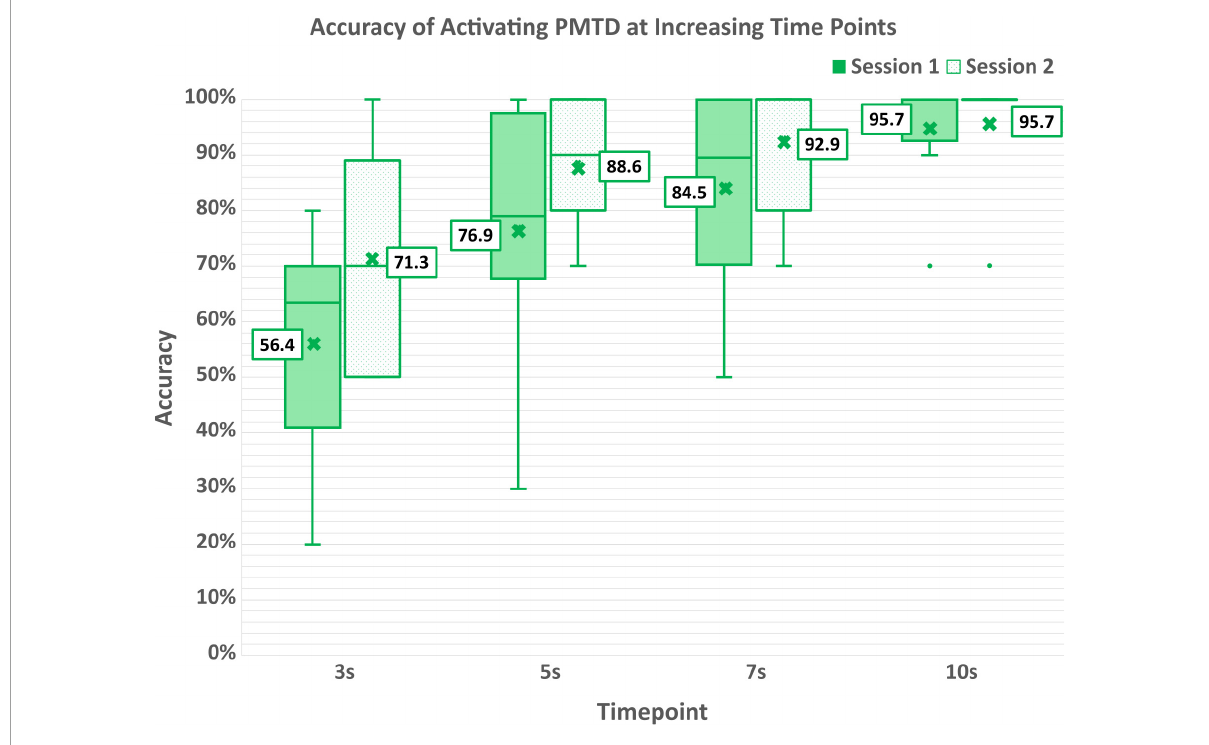
FIGURE6 Accuracy of activating the PMTD within increasing time windows of 3, 5, 7, and 10